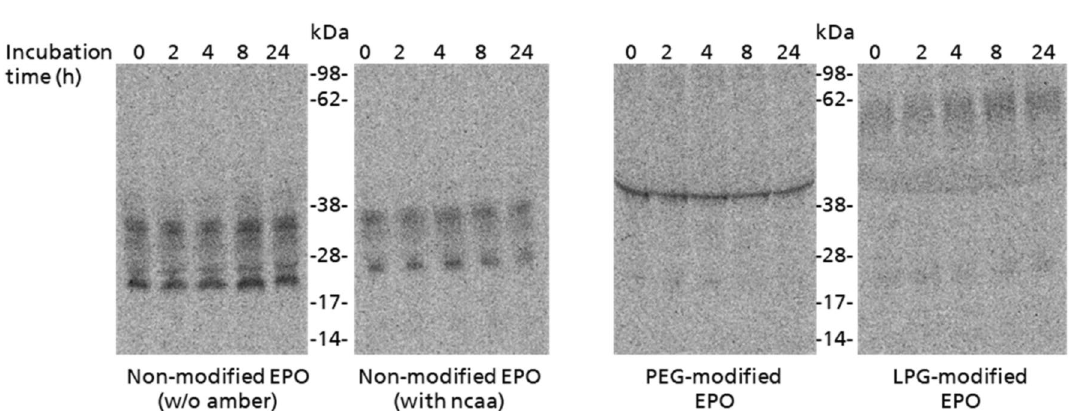
Figure 5. Stability analysis of modified and non-modified EPO. Unmodified full-length EPO, unmodified EPO harboring a non-canonical amino acid (ncaa), PEG-modified and LPG-modified EPO were incubated up to 24 h in human serum. Afterwards samples were acetone precipitated and analyzed via SDS-PAGE with following autoradiography. No change in band pattern was seen after 24 h indicating stable EPO samples. Uncropped autoradiography images are included in Supplementary